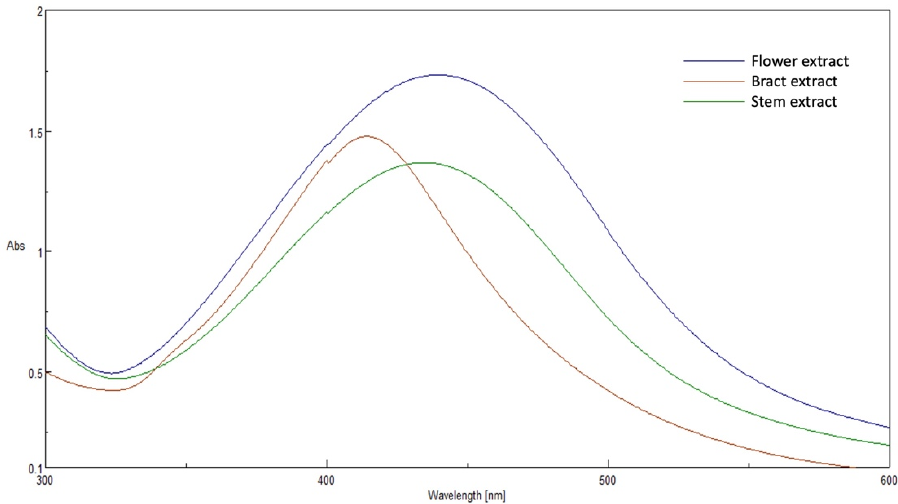
Figure 1. The UV-visible spectrum of prepared AgNPs using extracts of different parts of Cynara scolymus .